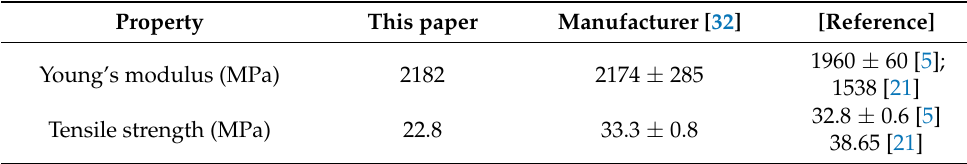
Table 3. Comparison of basic mechanical properties of ABS